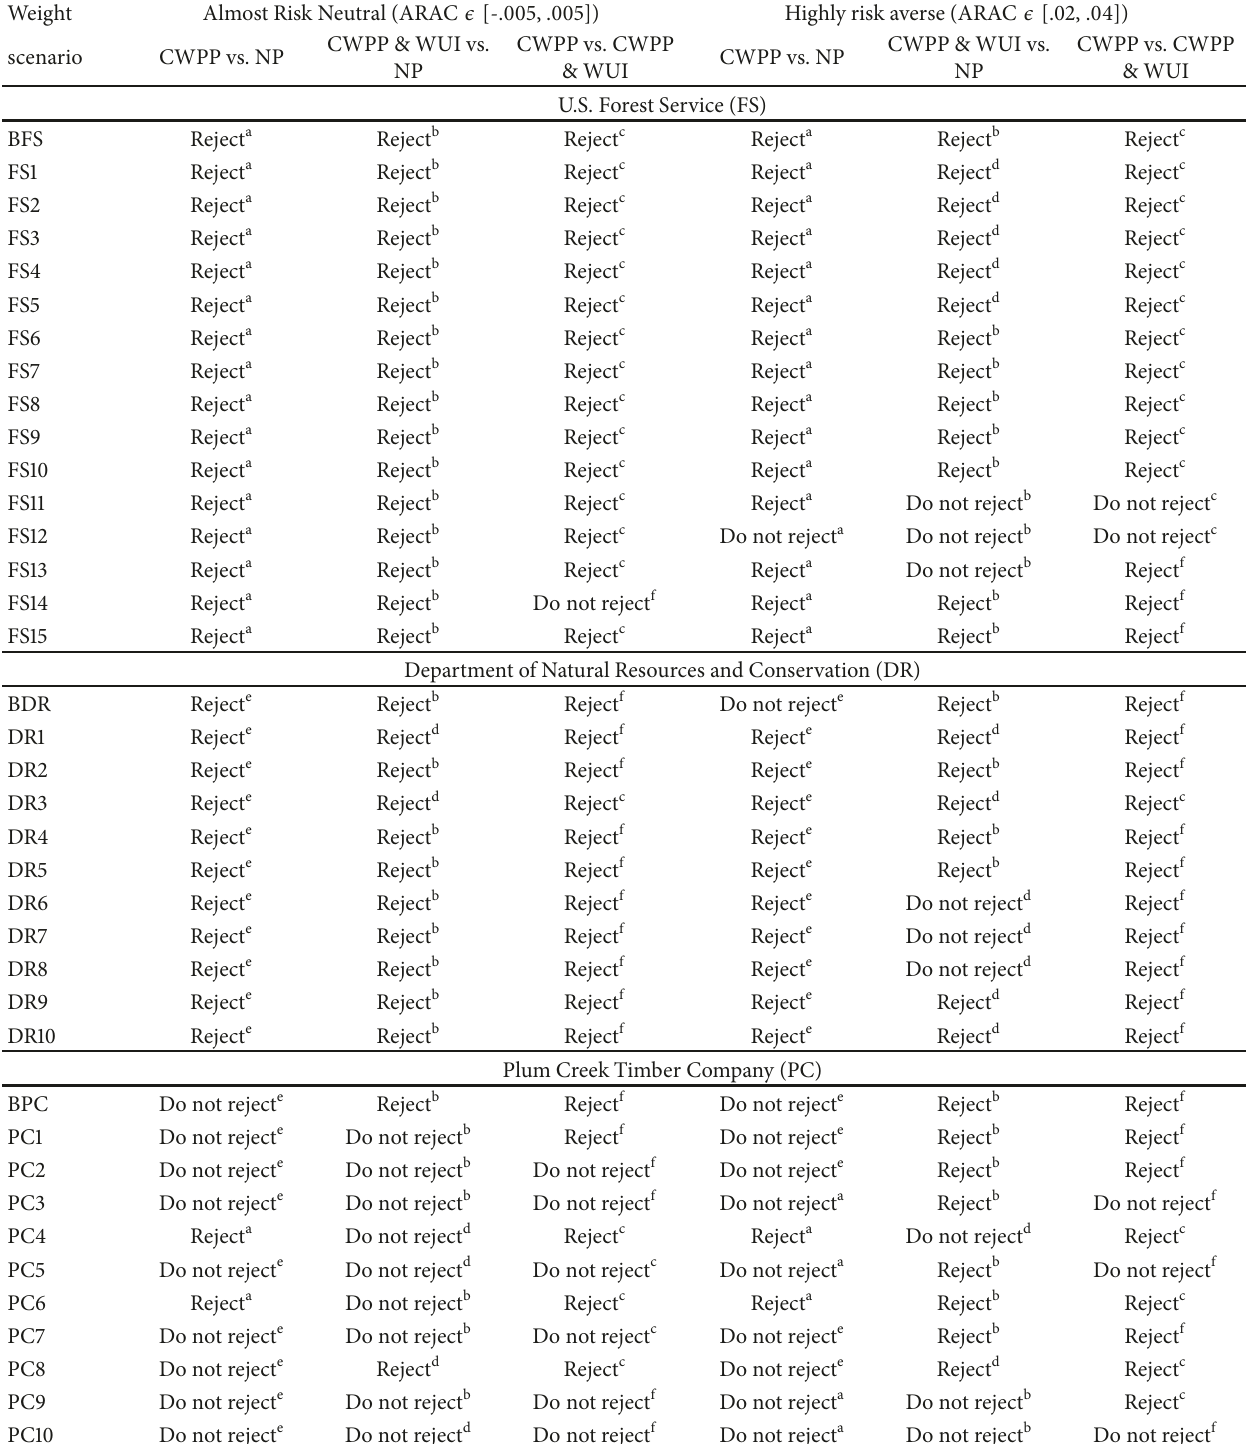
Table 3: Results of Mann-Whitney U tests of equality of median certainty equivalents for three pairs of fuel treatment strategies for two risk attitudes and three managers. Weight Almost Risk Neutral (ARAC 𝜖 [ -.005, .005]) Highly risk averse (ARAC 𝜖 [ .02, .04]) scenario CWPP vs. NP